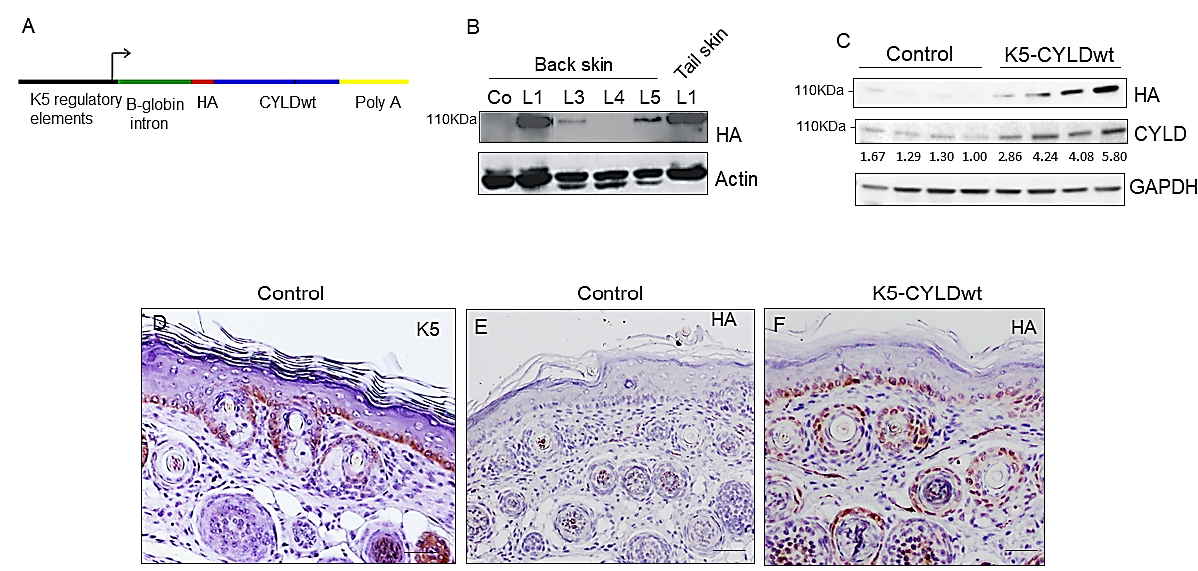
Figure 1. K5-CYLDwt mice express the transgenic protein following the K5 expression pattern. ( A ) Schematic representation of the K5-CYLDwt construct. The mouse complementary DNA (cDNA) tagged in 5′ with an HA epitope is expressed under the regulatory elements of the bovine K5. ( B ) Representative WB showing the transgene expression in the skin of transgenic mice of different lines (L1, L3, L4, and L5). Note that HA is not expressed in the skin of Control mice. ( C ) WB showing CYLD expression levels in the back skin of Control and K5-CYLDwt mice. Hybridization of skin of 6-month-old Control and transgenic mice of line 1 is shown. ( D – F ) Immunohistochemistry staining of tail skin sections from 7-day-old Control ( D , E ) and transgenic ( F ) mice showing the expression of K5 in the cytoplasm of keratinocytes of the basal layer and the ORS of hair follicles ( D ) and the HA expression in skin of K5-CYLDwt mice following the expression pattern of K5 ( F ). HA is not expressed in the skin of Control mice ( E ). Scale bars: 30 µ m ( D – F